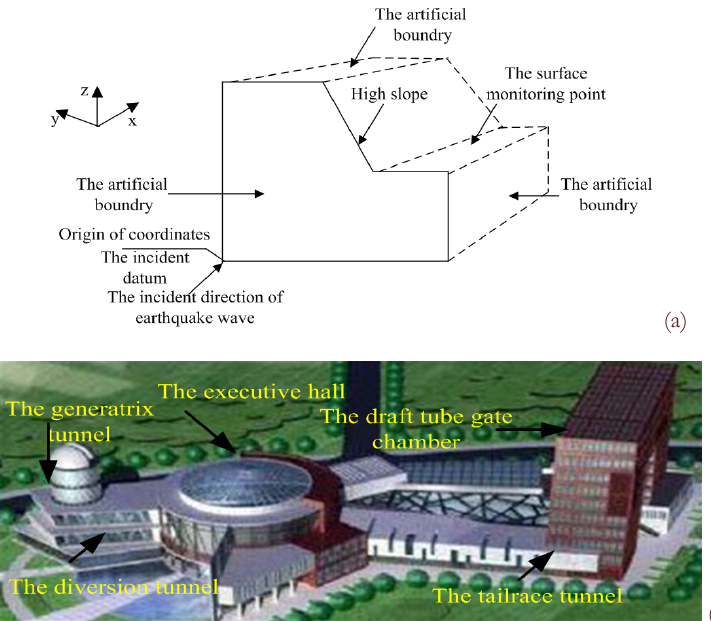
Figure 2: The finite element calculating model for the children's palace: (a) FEM model; (b) Excavation model